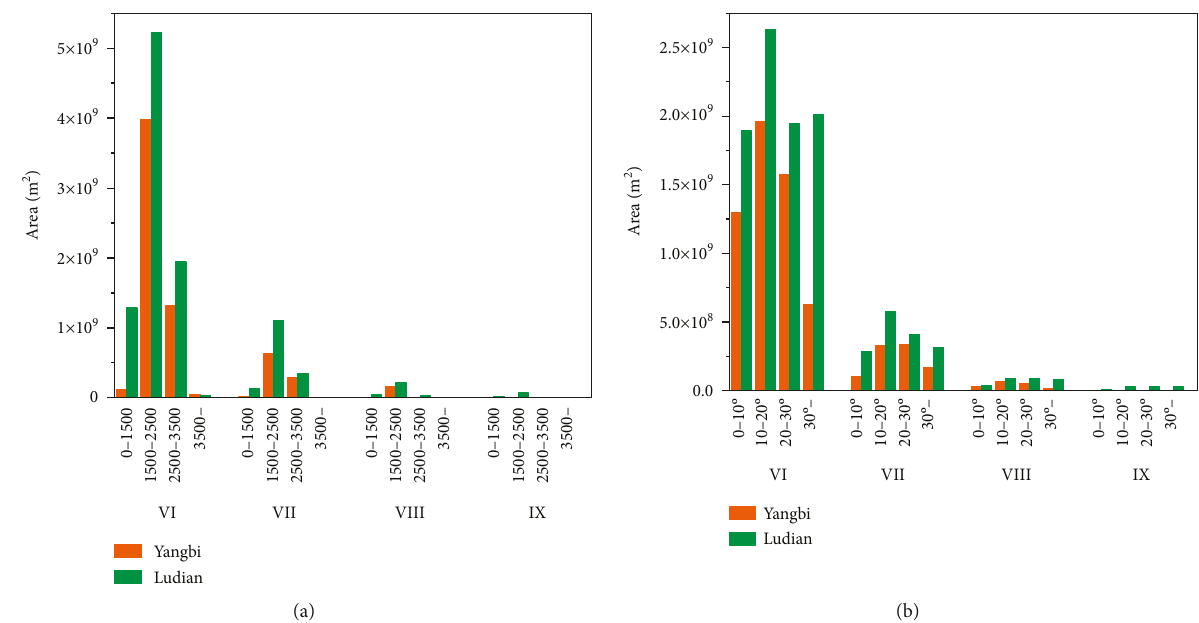
Figure 4: Distribution areas of elevation and slope angle in different intensity regions of two events. (a) Elevation. (b) Slope